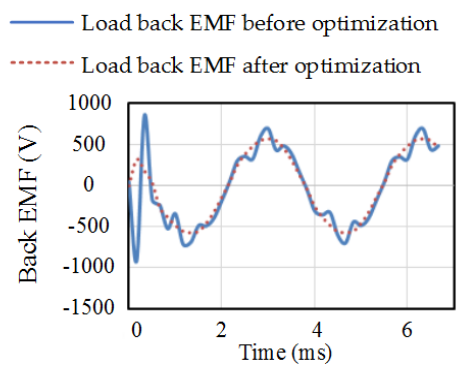
Figure 14. Torque of the AFPMSM at the rated load power.